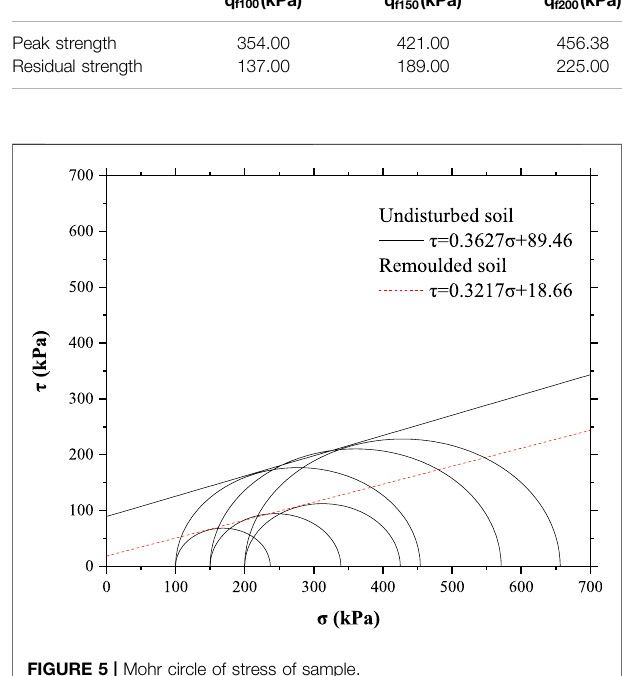
FIGURE 5 | Mohr circle of stress of sample.